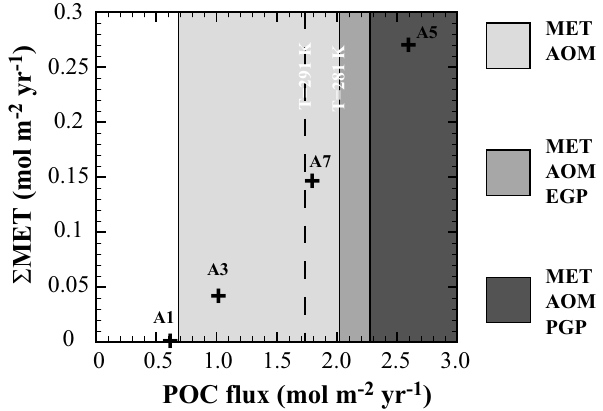
Fig. 10. Contemporary depth-integrated methanogenesis rate as a function of the POC flux for all stations. The shaded areas represent the relevant processes affecting the station. MET=methanogenesis, AOM=Anaerobic oxidation of methane with sulphate, EGP=Ephemeral gas phase, PGP=permanent gas phase. Note that organoclastic sulphate reduction takes place at all sites. The dashed line represents the shift in the ephemeral gas phase (one that is present only seasonally) if the bottom-water temperature maximum would reach